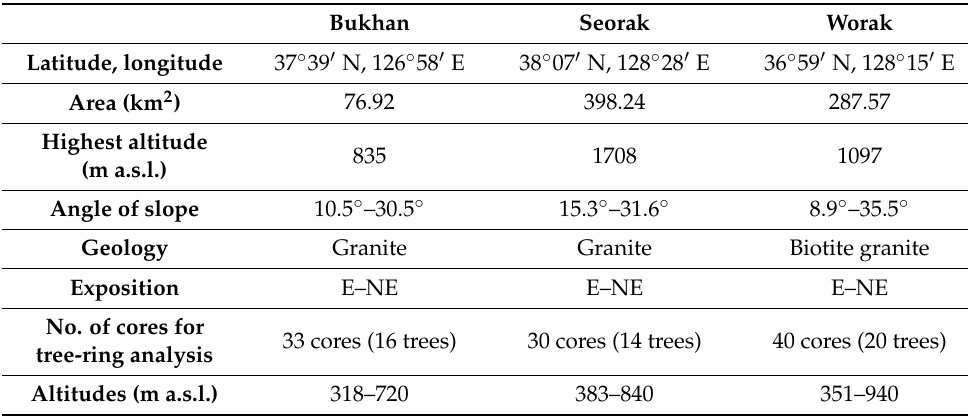
Table 1. Site characteristics and sample